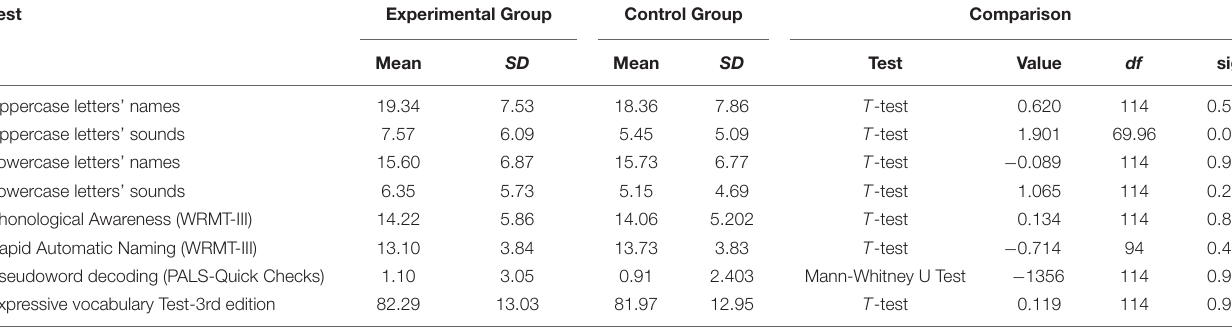
TABLE 3 | Comparisons between the experimental and control group on the baseline measurements.